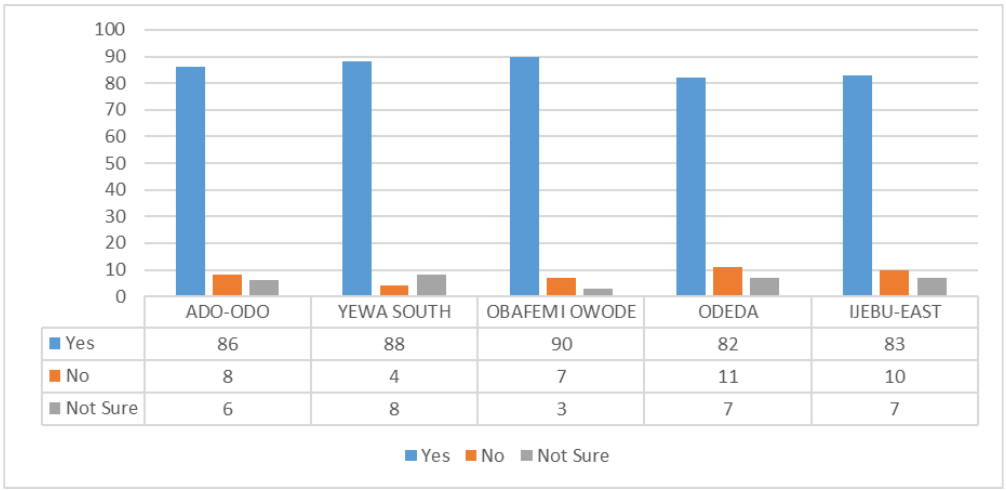
Figure 6. Responses on willingness to participate in any SWM improvement initiative.